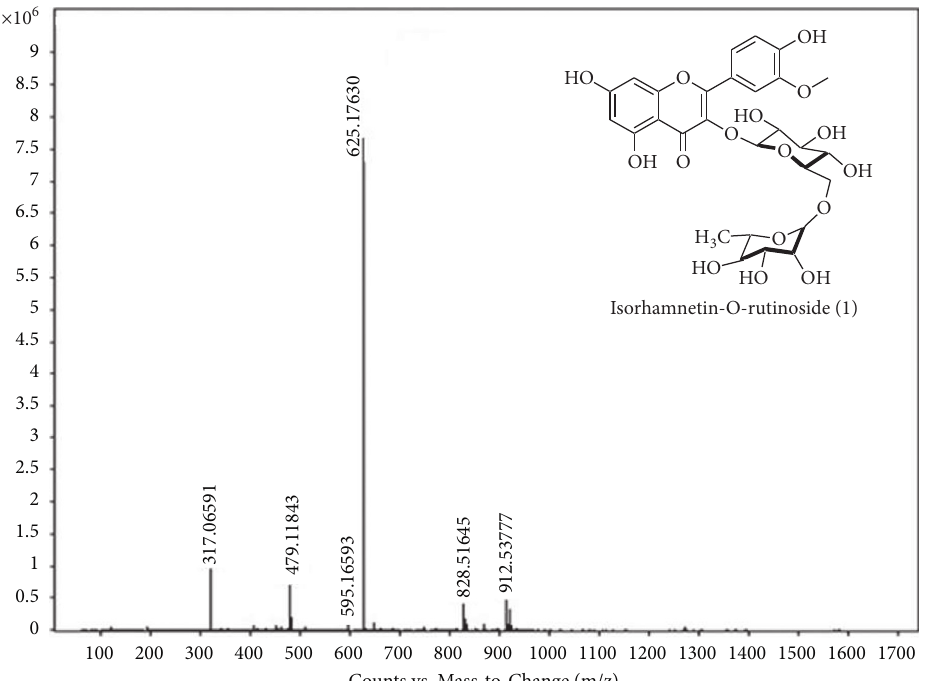
Figure 1: LC-ESI-MS chromatogram of a base peak [ M + H ] + with m / z 625.17598 at 6.05min present in SPE4 fraction of A. corniculatum for the identified flavonol compound ( 1